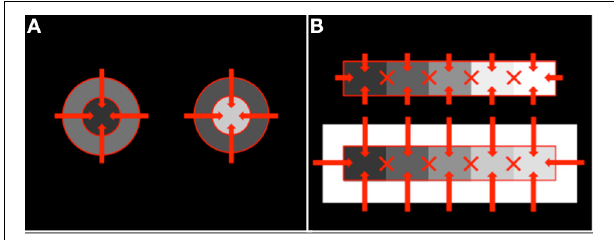
FIGURE 9 | Allowed and unallowed edge integration paths in disk-annulus and staircase-Gelb lightness paradigms. (A) Disk-annulus. (B) Staircase-Gelb. For both types of stimuli, edge integration takes place only along direct paths from the common background, or surround, field to the target whose lightness is begin computed. Edges whose weighted log luminance ratios are integrated to compute target lightness are indicated by solid red lines. The X’s indicate edges that do not participate in edge